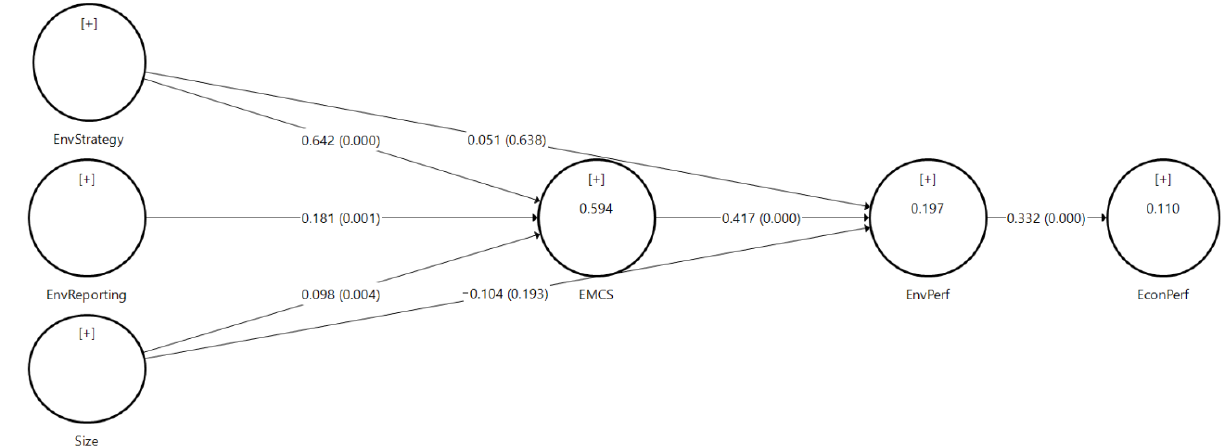
Figure 2. Evaluation of the structural model.